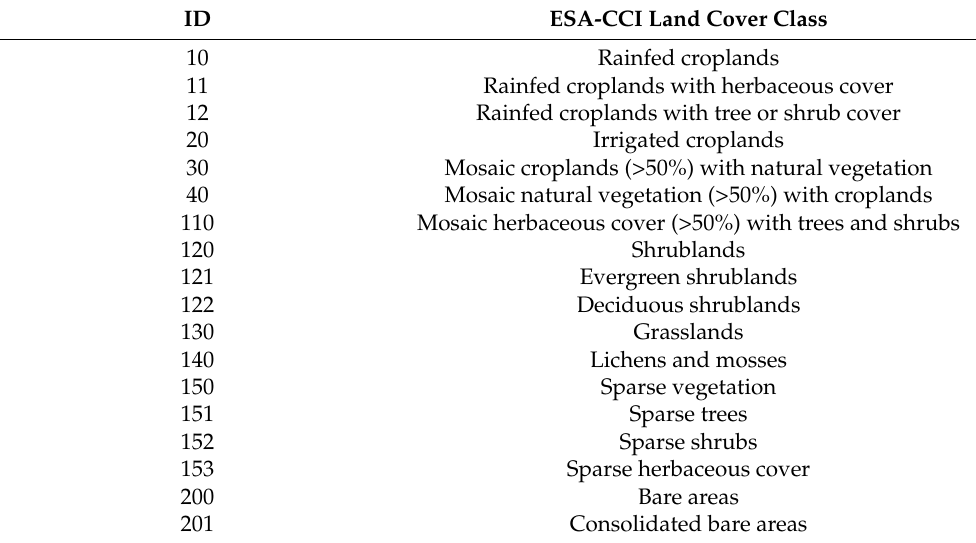
Table 1. The rural LC component